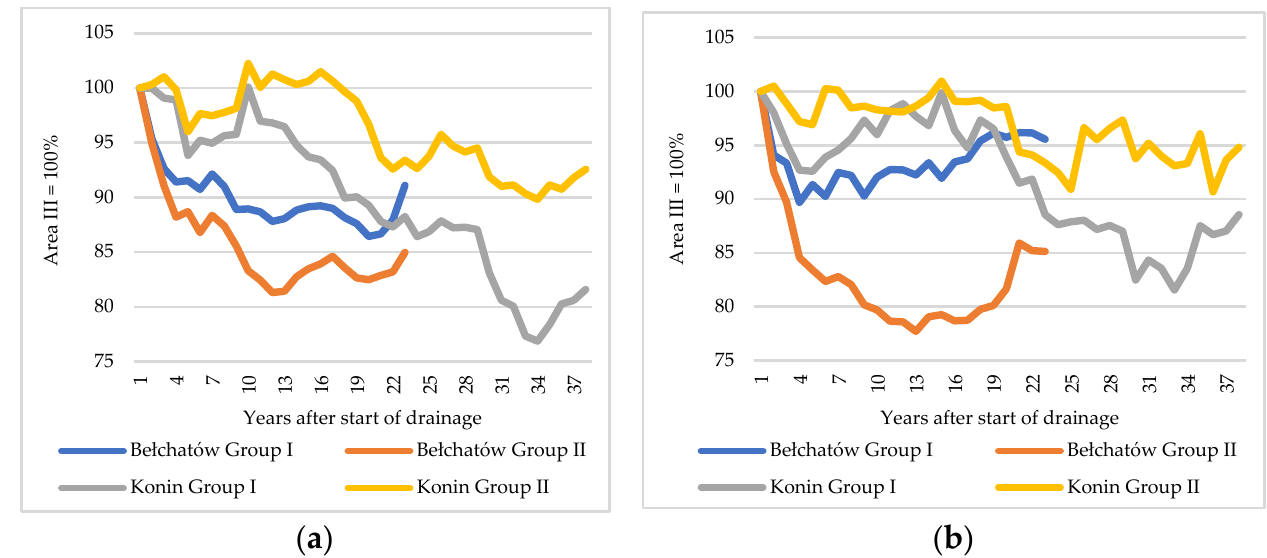
Figure 2. The dynamics of the yield of cereal and potatoes in Area I and II compared to the dynamics of the yield in Area III for Bełchatów opencast mine (base period—1971–1975 years) and the Konin Basin (base period—1956–1960 years) at the voivodship level: ( a ) cereal; ( b ) potato. Source: based on [50–58].